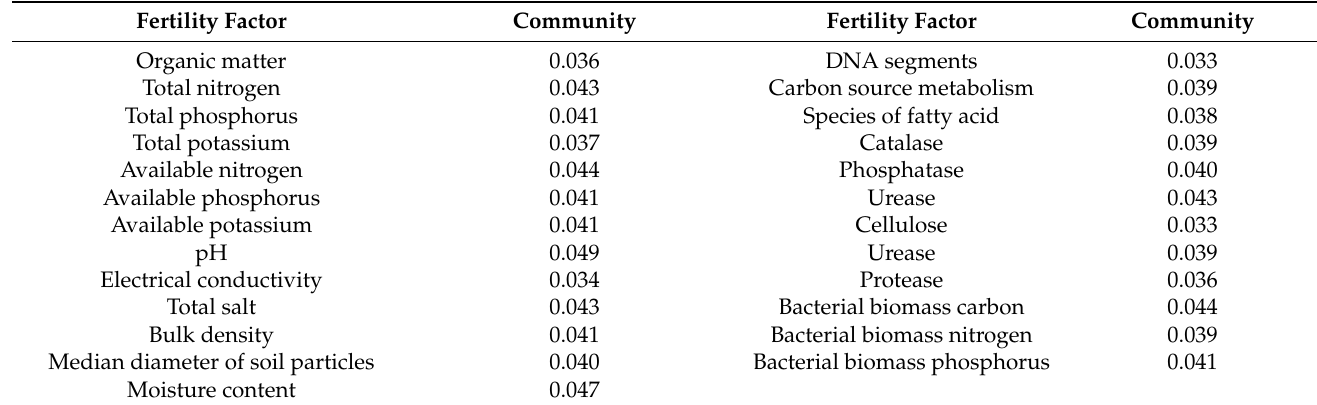
Table 2. The weights of all the fertility